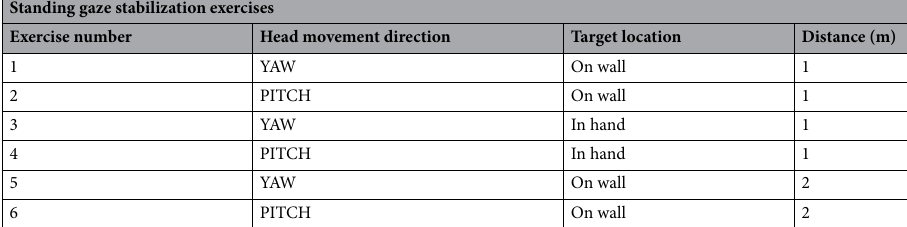
Table 1. A list of the 6 gaze stabilization exercises used in the current study. The exercises vary in direction, target fixation and the distance between the patient and the target. Target on wall means the target was attached to a wall whereas target in hand means the target was held by the patient with their dominant hand at 90° shoulder flexion with full arm